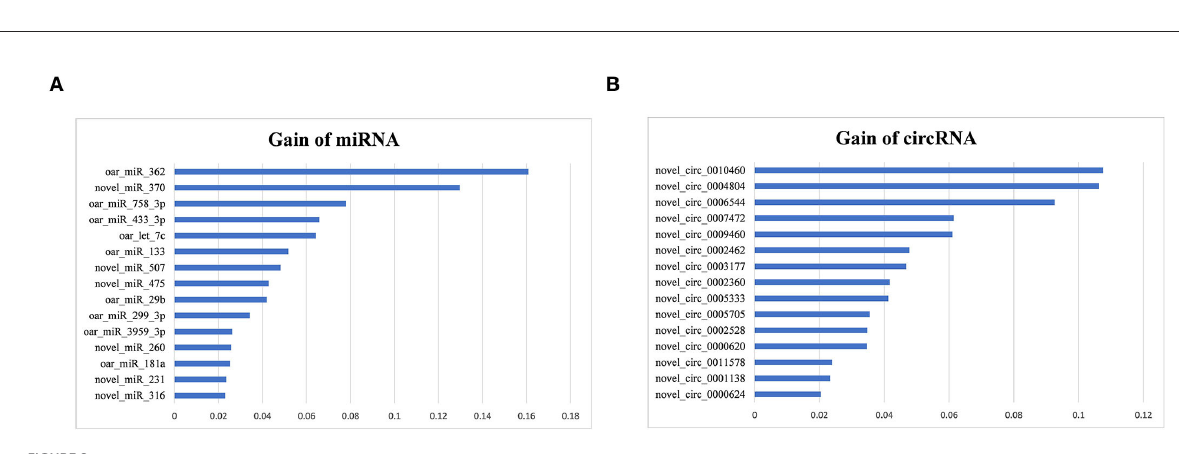
detailed parameter training results and biomarker identification results are given in Supplementary Table